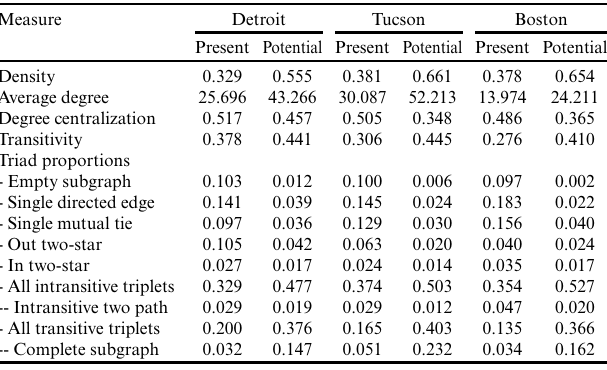
Table 4 . Descriptive statistics for present and potential